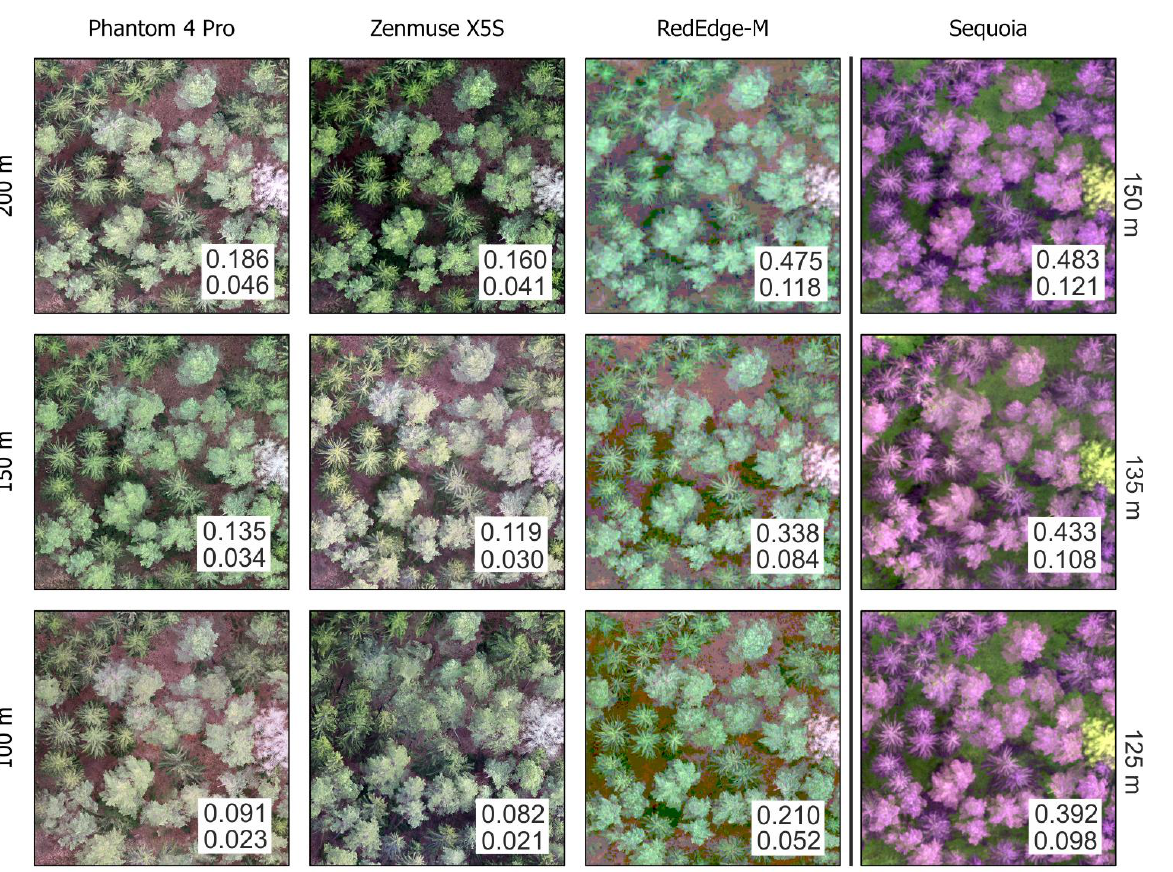
Figure 3. The details of Site I of the study: created models with the resulting spatial resolution of the digital elevation model (first lines) and orthomosaics (second lines) in metres.